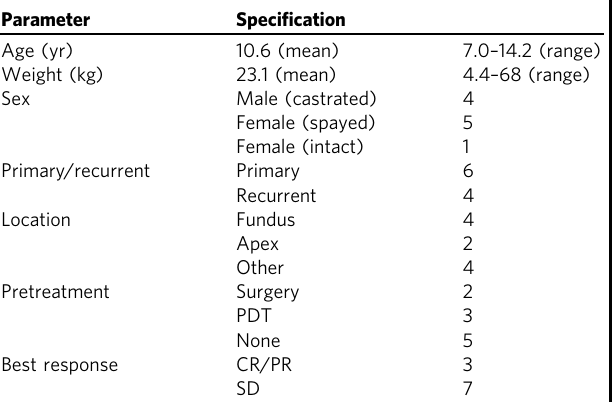
Table 1 Dog patient